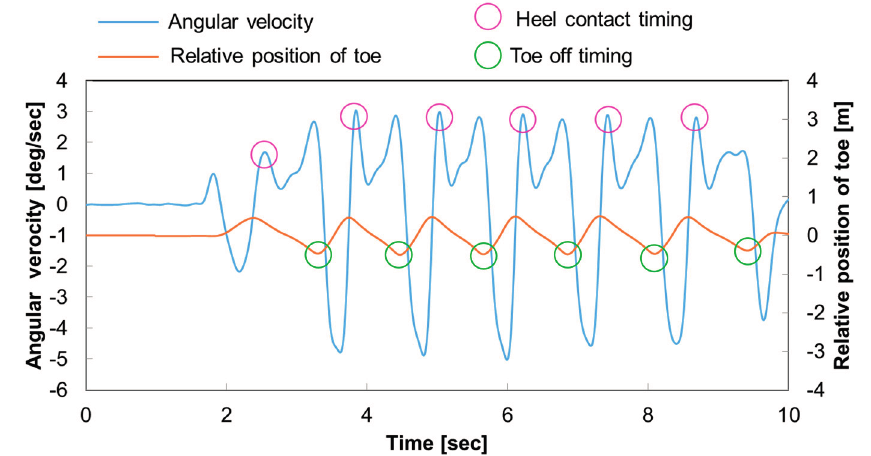
Figure 3. The method used to detect the HC and TO timing of the foot. The vertical axis represents the angular velocity and the relative position of the toe. The horizontal axis represents time. The HC timings are detected by the characteristic lateral angular velocity peaks and circled in pink. The TO timings are detected by measuring the negative peaks of the relative distance of the toe position to the origin of the pelvis (PE) coordinate system as circled in